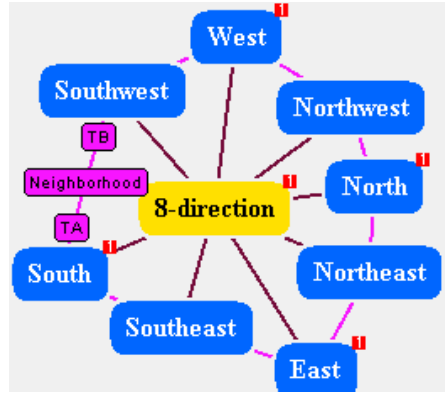
Figure 2. Topic map of top spatial relation